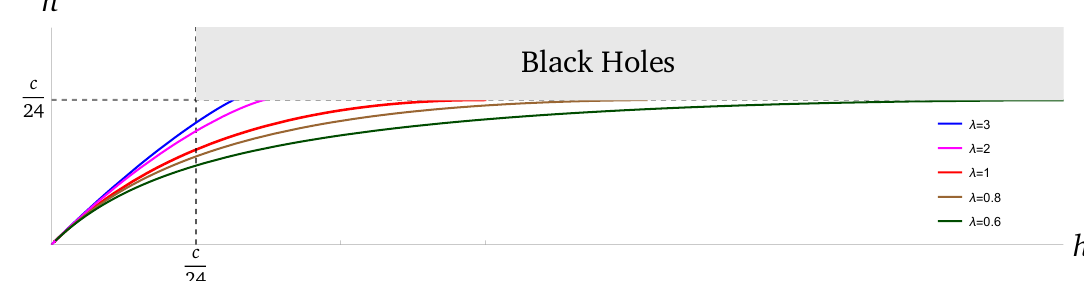
Figure 2 . The string spectrum for various values of λ . We plot the relation between the conformal dimensions h = ∆+ J and ¯ h = ∆ − J for the corresponding boundary states. BTZ black holes cover the region where h and ¯ h are both larger than c . For each λ , we have a one-parameter family 24 of solutions running from zero energy and angular momentum to finite maximal values, where the string solution merges with an extremal black hole at ¯ h = c 24